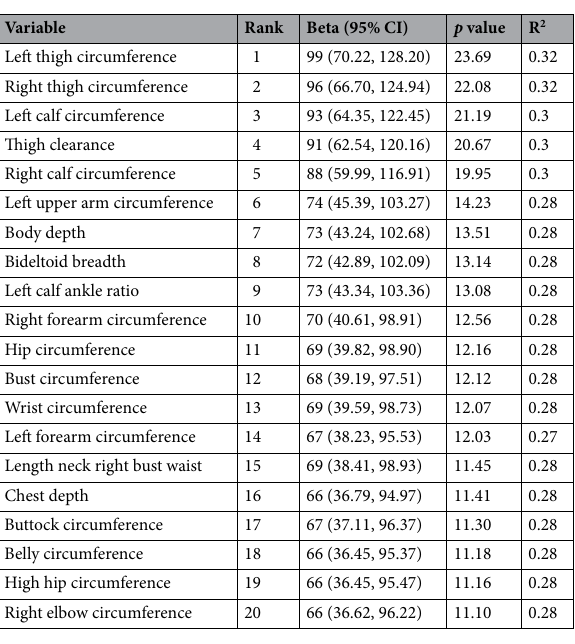
Table 3. Characteristics of the strongest anthropometric markers related to VO2peak for women.